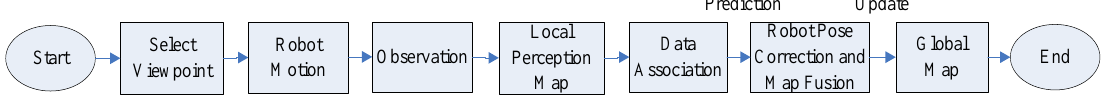
Figure 5. The flowchart of the SLAM process.